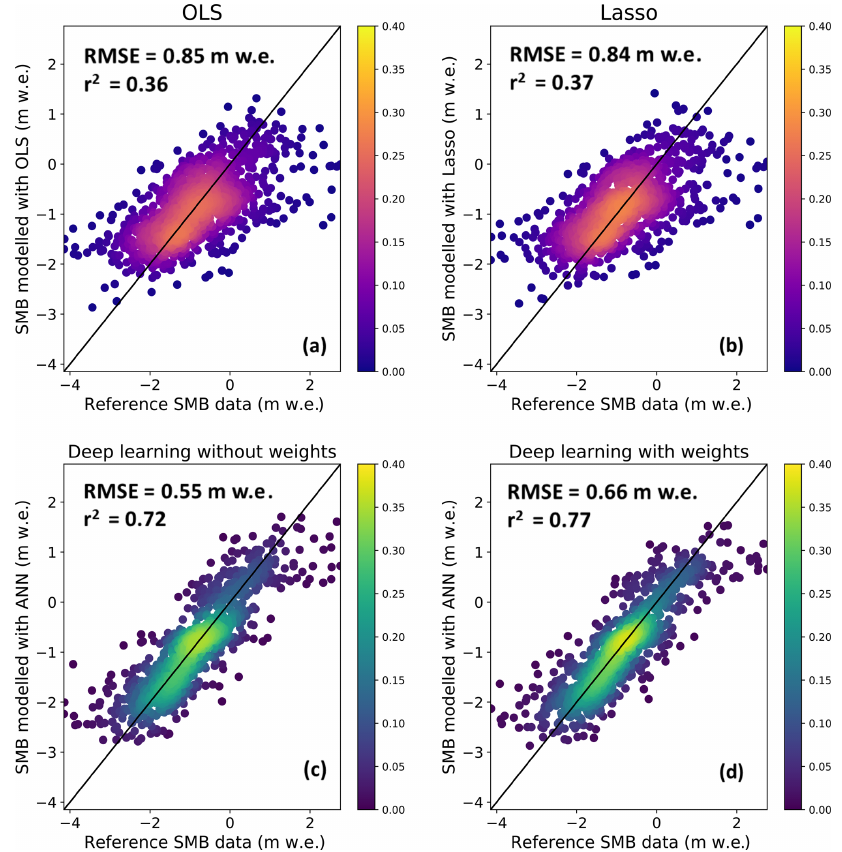
Figure 9. Evaluation of modelled annual glacier-wide SMB against the ground truth SMB data (both in mw.e.a − 1 ) using leave-one-year- out cross validation. The colour (purple–orange for linear; blue–green for nonlinear) indicates frequency based on the probability density function. The black line indicates the reference one-to-one line. (a) Scatter plot of the OLS model results. (b) Scatter plot of the Lasso linear model results. Scatter plots of the deep artificial neural network nonlinear models without (c) and with (d) sample